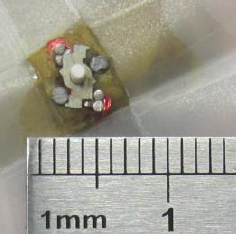
Figure 16. Prototype of the axial-flux, single-phase switched reluctance motor.